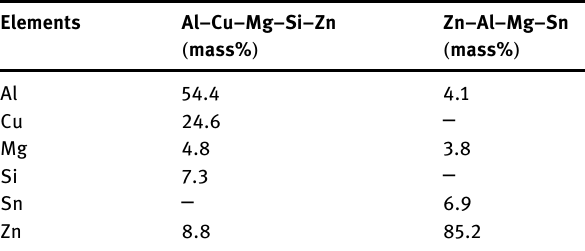
Table 3: Obtained eutectic compositions of Al – Si – Cu – Mg – Zn